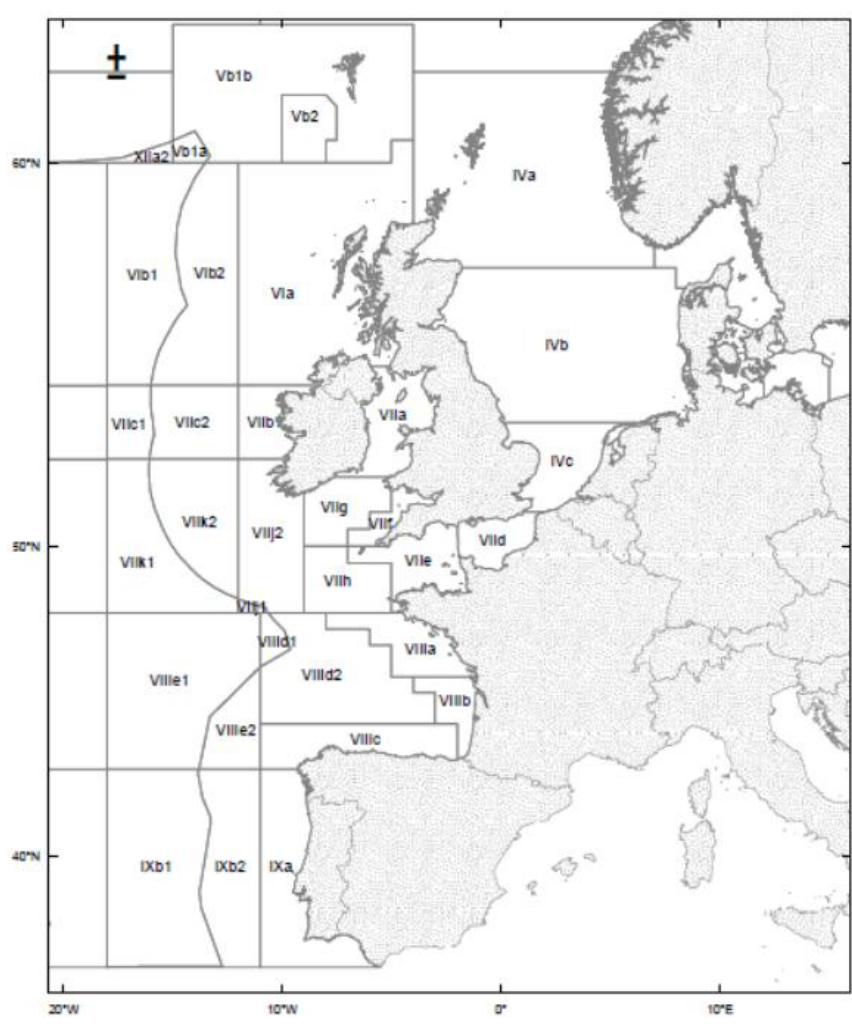
Figure 4. Locations of ICES fishery management areas on the northern European shelf–shelf-break